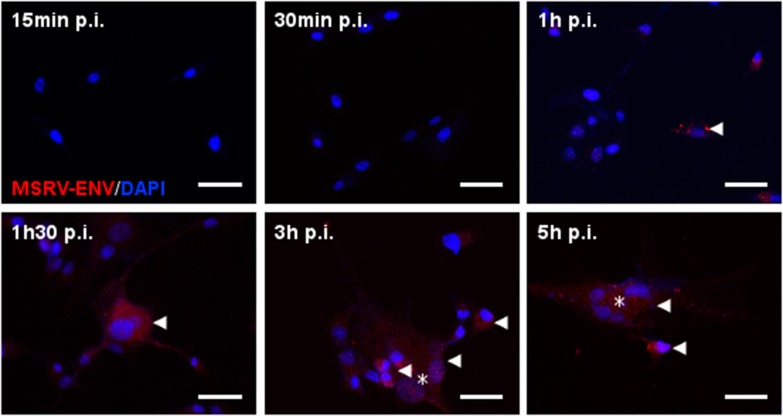
Kinetics of HHV-6A-induced MSRV-Env production in U87 cells. U87 cells were infected with HHV-6A (MOI 1) and analyzed at indicated time points after infection by immunofluorescence using anti-MSRV-Env mAb, followed by anti-mouse-Alexa 555 (red staining, arrowhead). HHV-6A induced syncytia formation observed at 3 h p.i. (*). DAPI (blue staining) was used to visualize cell nuclei. Bar = 50 μm.